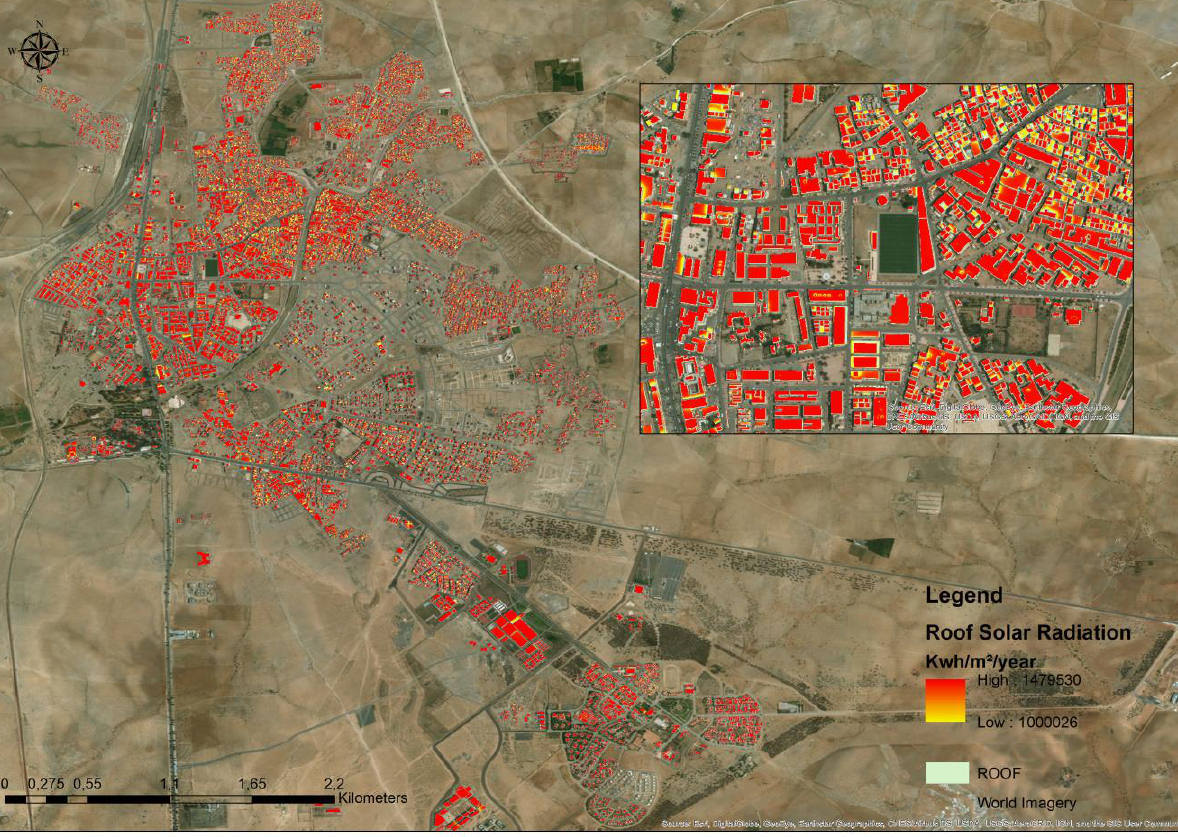
Figure 6. Solar irradiation on flat roof of Benguerir.